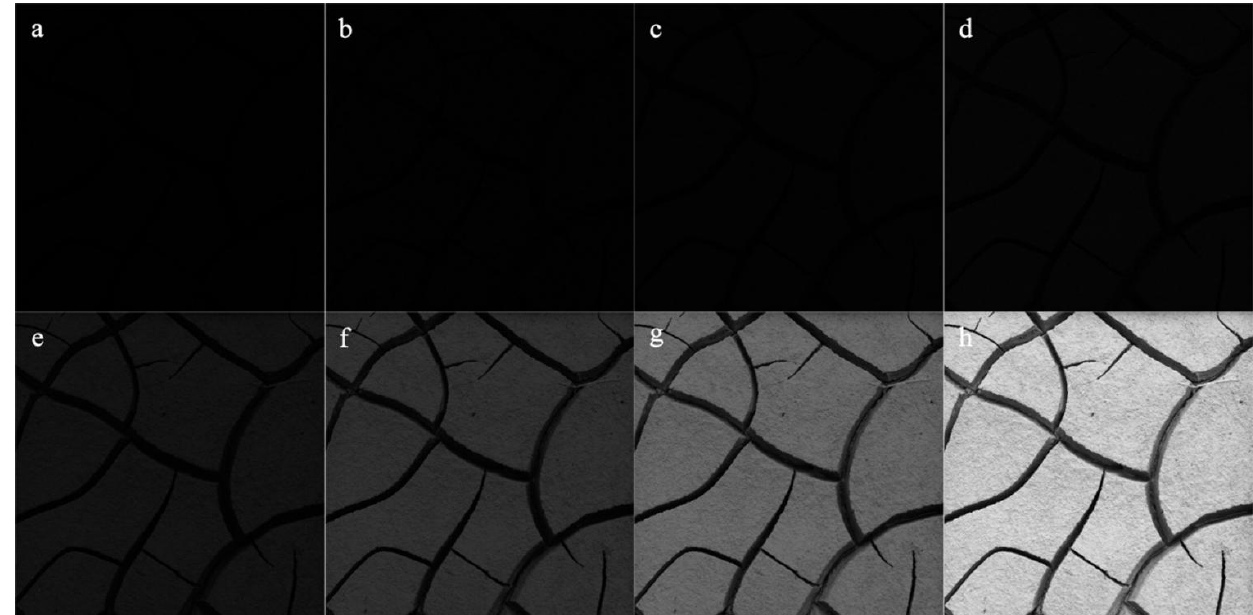
Figure 4. Extraction results of eight gray-scale images of a typical cracked soil sample. ( a ) gray level of 2; ( b ) gray level of 4; ( c ) gray level of 8; ( d ) gray level of 16; ( e ) gray level of 32; ( f ) gray level of 64; ( g ) gray level of 128; ( h ) gray level of 256.